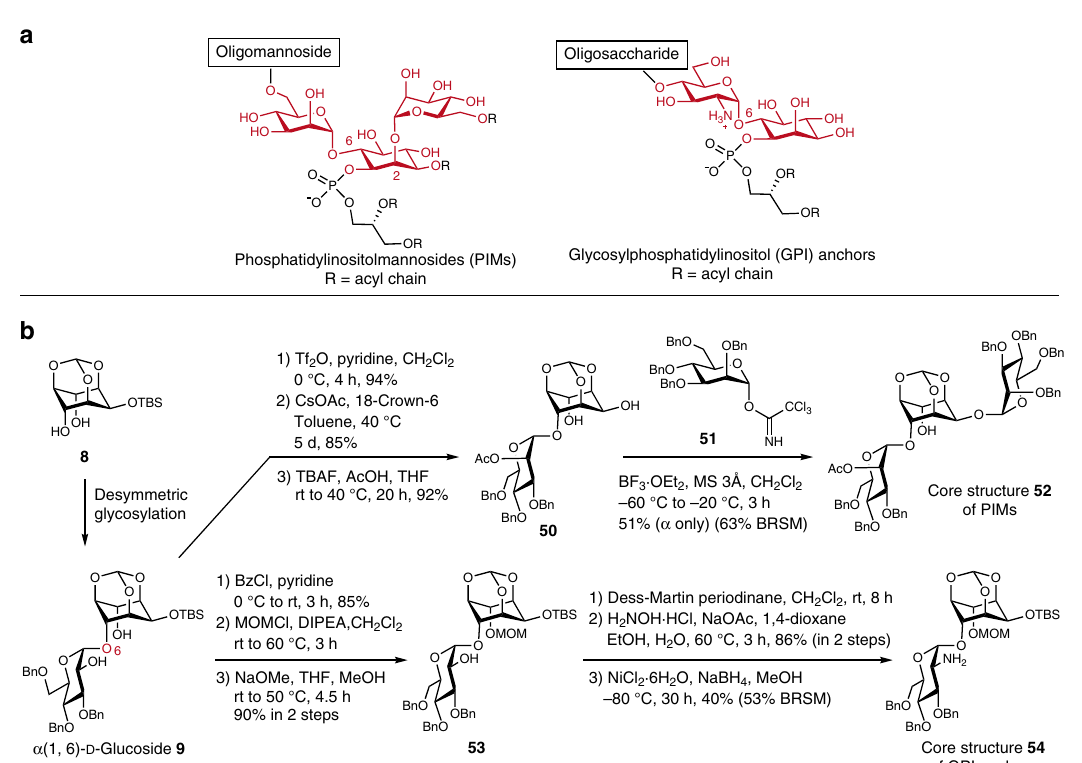
Fig. 7 Synthetic scheme of core structures of PIMs and GPI anchors. a Chemical structures of PIMs and GPI anchors. b Synthesis of core structures 52 and 54 using the present glycosylation method. Tf tri fl uoromethanesulfonyl, Ac acetyl, TBAF tetra- n -butylammonium fl uoride, Et ethyl, MS molecular sieve, MOM methoxymethyl, DIPEA N , N -diisopropylethylamine, BRSM based on recovered starting (Supplementary Figs. 22 – 24, Supplementary Tables 22 and 23).